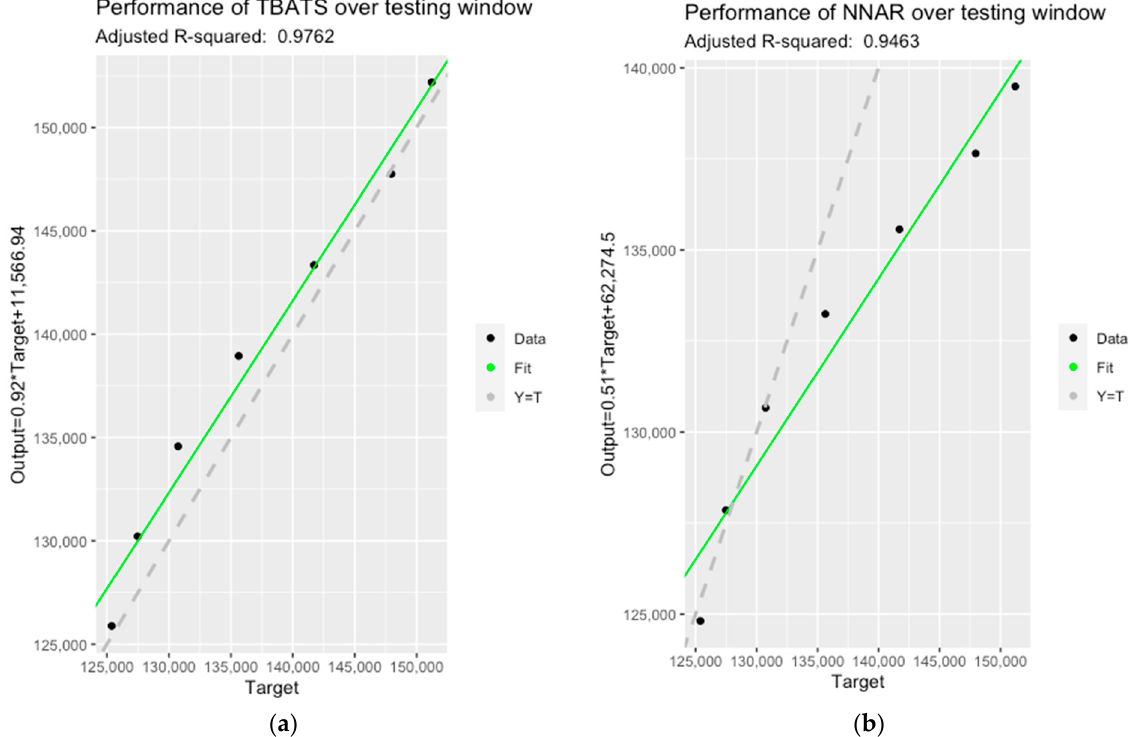
Figure 5. Model performance over testing window (e-commerce retail sales, path A): TBATS (panel a ), and NNAR (panel b ). Source: estimation